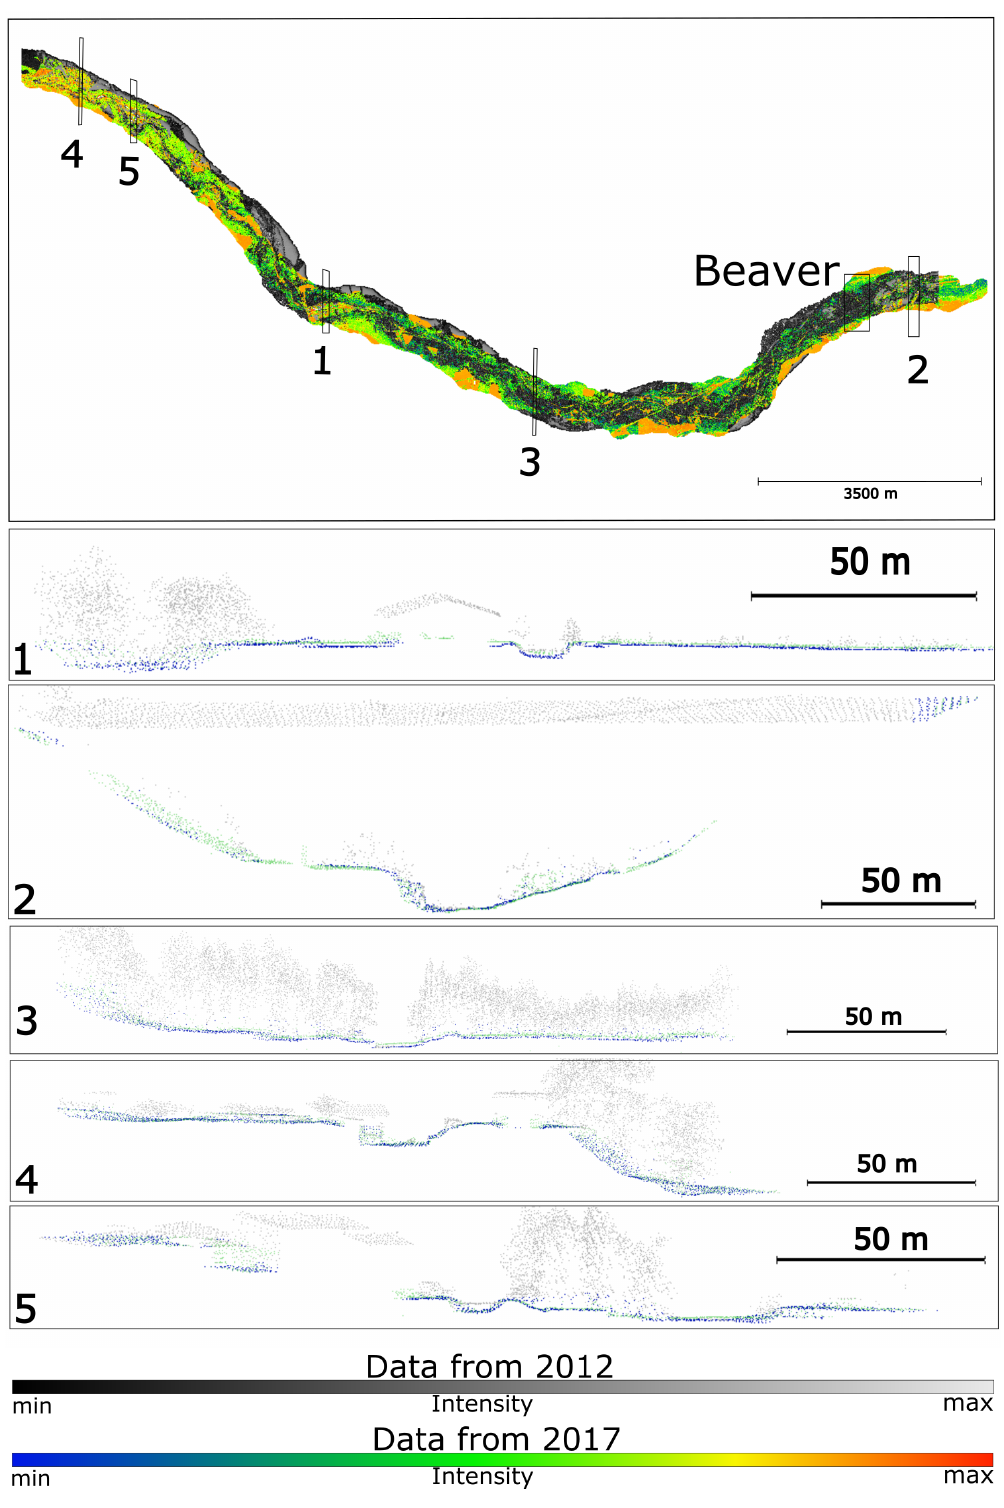
Figure 3. Result of the proposed registration approach shown on the whole flight strip. The marked areas show the location of the profile views of the selected scenes. Shown data are the data of the whole flight strip downsampled to 1 m GSD. The profile views show the data of 2012 and 2017. Ground points from the data of 2012 are colored in blue, non-ground points from 2012 are colored in gray, and ground points of 2017 are colored in